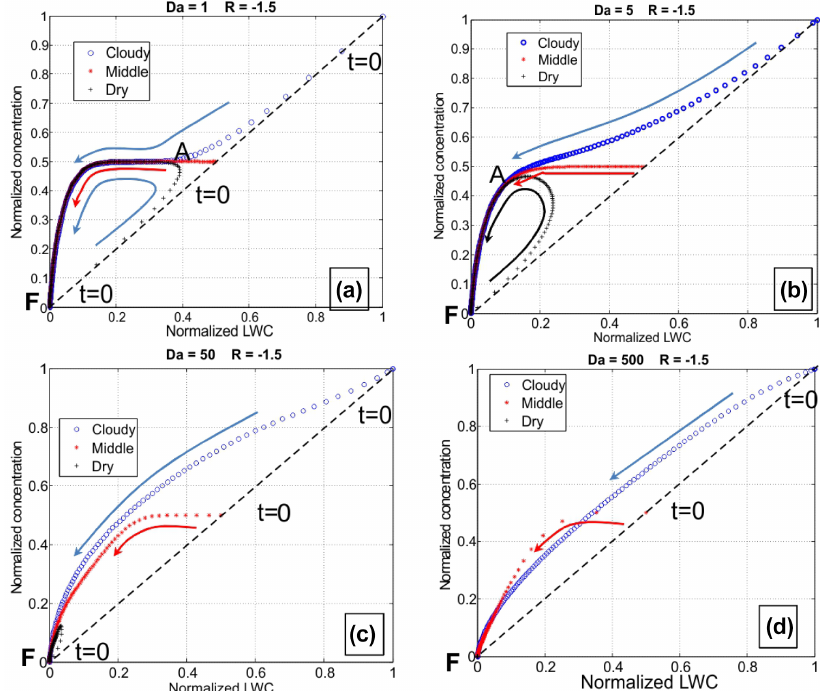
Figure 5. Dependencies of normalized values of droplet concentration on normalized LWC at different Da and R = − 1 . 5. Blue symbols mark the center of the cloudy volume ( e x = 1 / 4 ) , red symbols mark the interface between the cloudy volume and the dry volume ( e x = 1 / 2 ) , and black crosses mark the center of the initially droplet-free volume ( e x = 3 / 4 ) . Symbols are plotted at different time instances. Symbols at t = 0 show initial values of droplet concentration and LWC at the three values of e x . Arrows show the direction of movement of the points at the diagram with time. Point “A” marks the beginning of the spatially homogeneous stage, e t = T mix . Point “F” marks the final state. The dashed line indicates the relationship between e N and e q in extremely inhomogeneous mixing (according to the classical